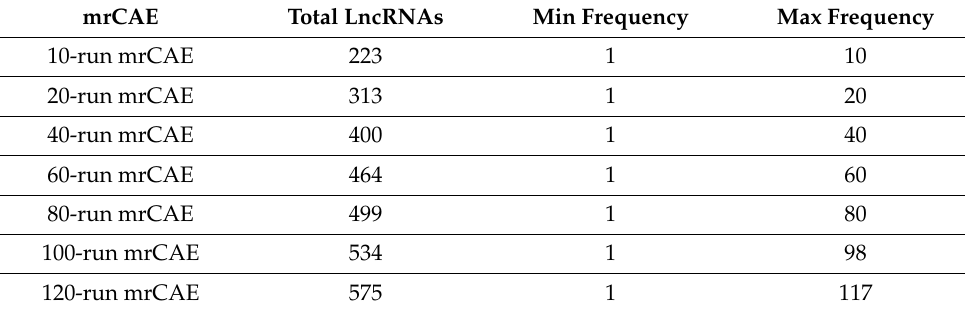
Table 1. Summary statistics of mrCAE systems in selecting lncRNAs. mrCAE Total LncRNAs Min Frequency Max